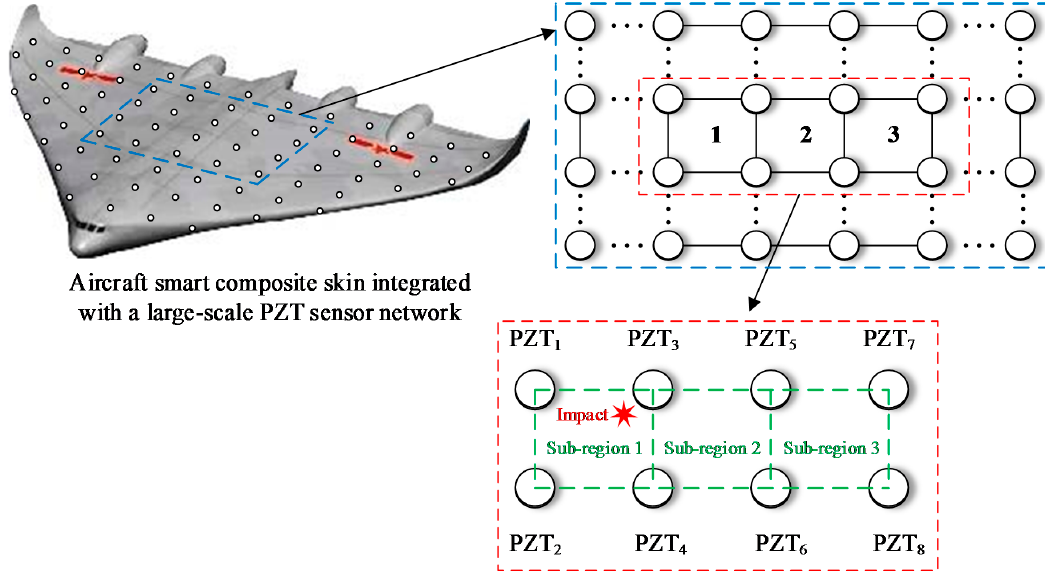
Figure 2. The schematic diagram of an ASCS integrated with a large-scale PZT sensor network.